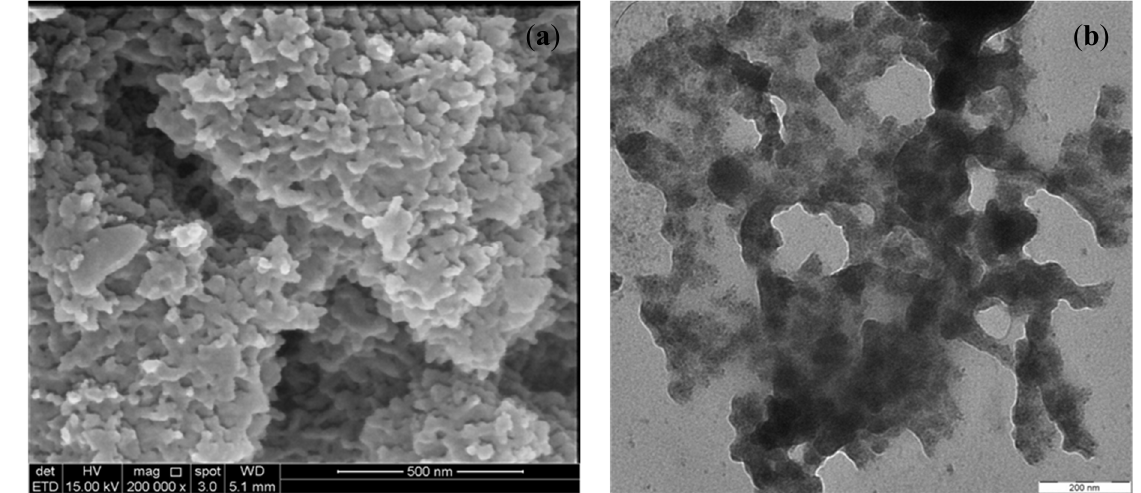
Figure 2. SEM ( a ) and TEM ( b ) images of GO-PANI.